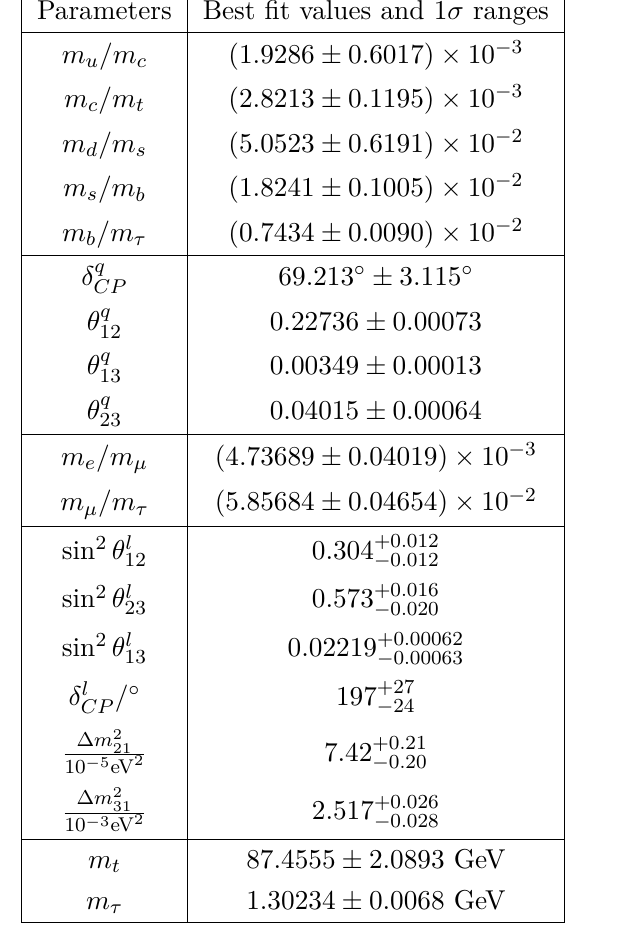
Table 3 . The best fit values and 1 σ errors of the mass ratios and mixing parameters of quarks and leptons. The values of the quark and charged lepton masses and the CKM parameters at the GUT scale are taken from ref. [73] with SUSY breaking scale M 0 . 09375 [73]. The lepton mixing parameters are taken from [4] for normal ordering neutrino